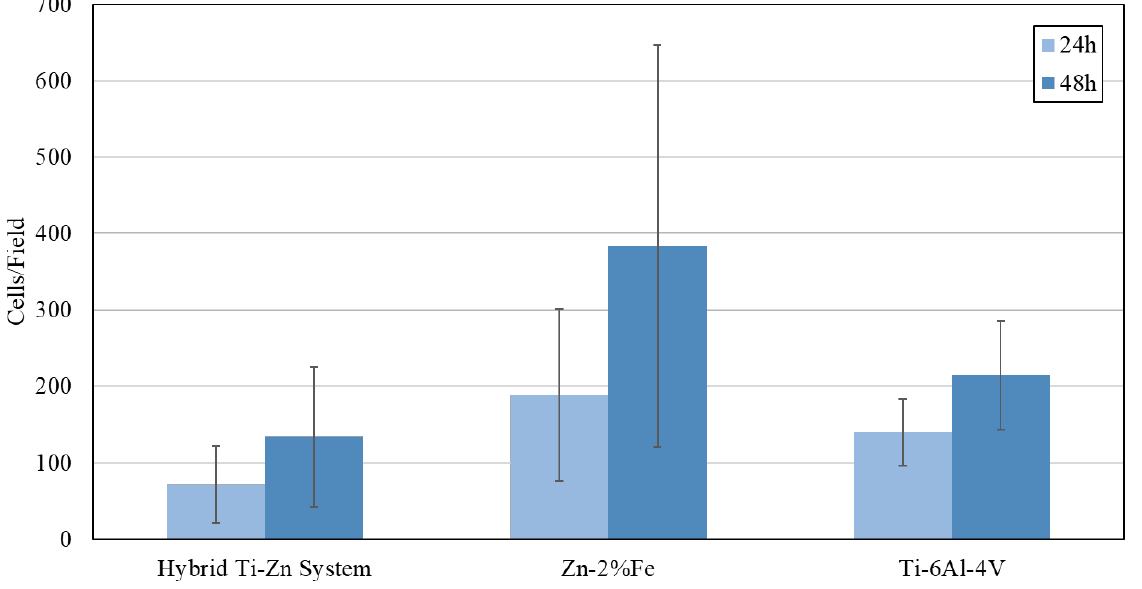
Figure 8. Cell count of 4T1 cells per unit field after 24 h and 48 h incubation while adhered to the alloys’ surfaces.